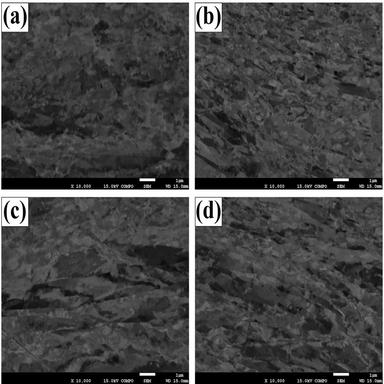
Channeling contrast FE-SEM images illuminating the coarse grain structure of nickel foil layers after the completion of the AFF process for the layered composite structures with (a, b) low and (c, d) high contents of Mg.